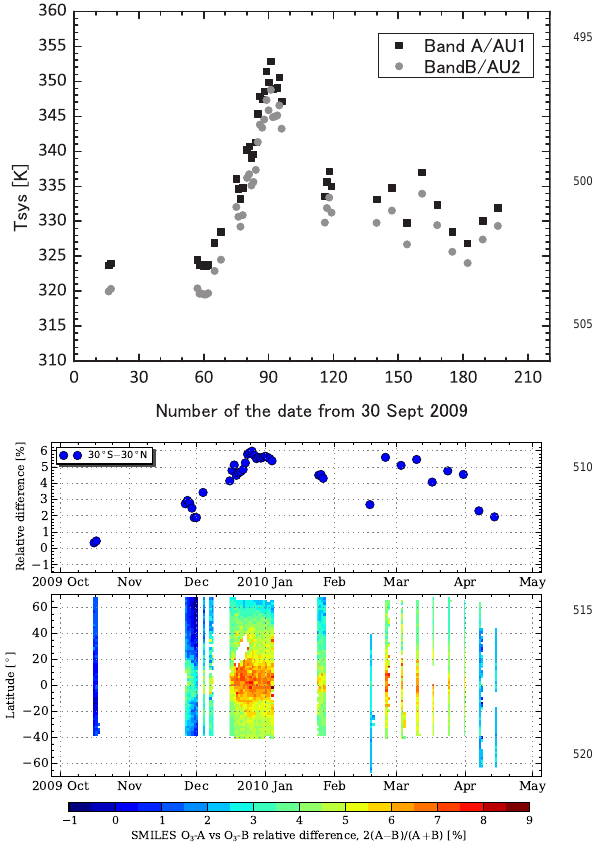
Fig. 7. Upper panel: The day-to-day variation of the system temperature of the receiver (Tsys). Tsys of the Band-A with AOS unit 1 (AU1) and the Band-B with AOS unit 2 (AU2) are shown respectively. Tsys here is the daily average of band-averaged receiver output. Calibration data in the tropical observation scans are averaged. Middle panel: the daily mean difference in the tropics (30 ◦ S–30 ◦ N). Lower panel: Seasonal and latitudinal variation of the SMILES O 3 Band-A and -B difference at 8.31hPa. Only the dates when the measurement numbers are larger than 50 are shown. The blank regions in the lower panel are the dates when SMILES was not operated in the A + B configuration.